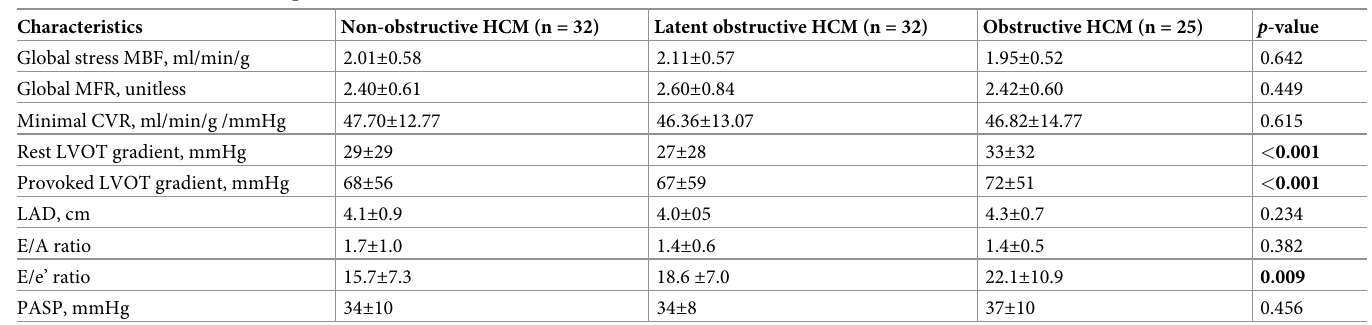
Table 3. Characteristics of HCM patients with and without obstruction.